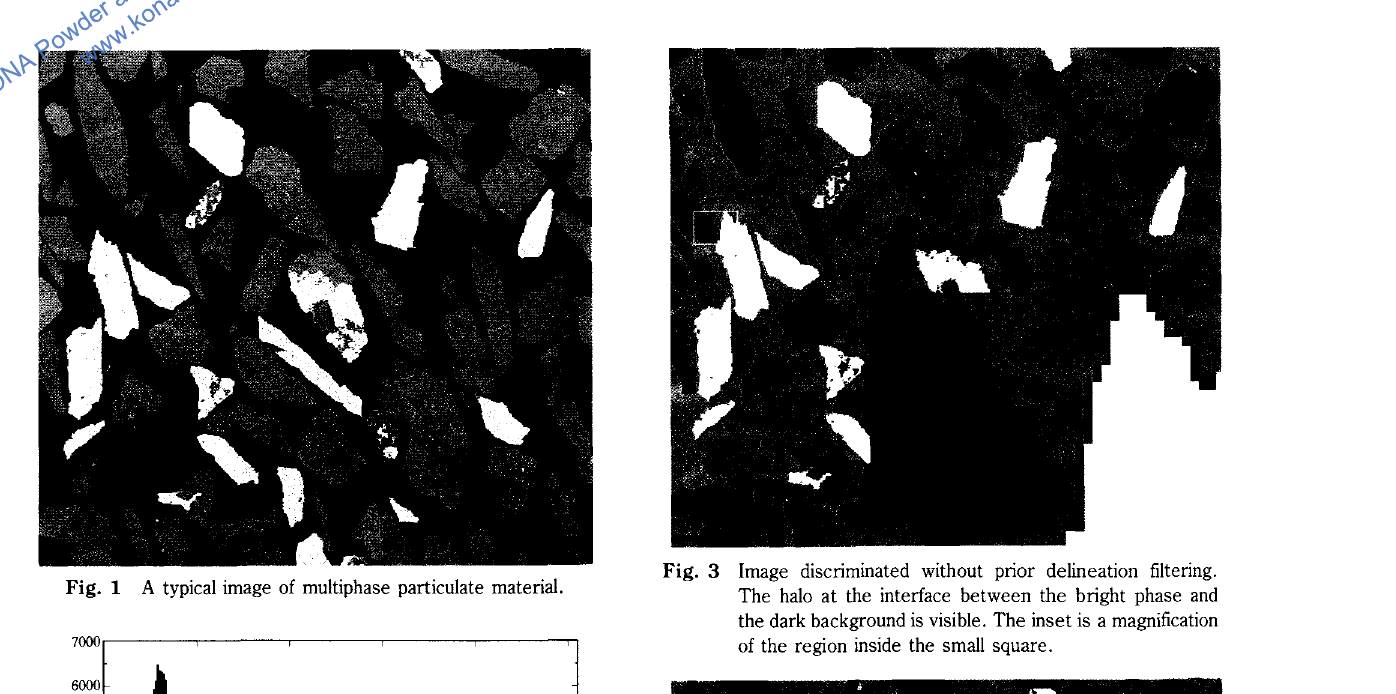
Fig. 3 Image discriminated without prior delineation filtering. The halo at the interface between the bright phase and the dark background is visible. The inset is a magnification of the region inside the small square.